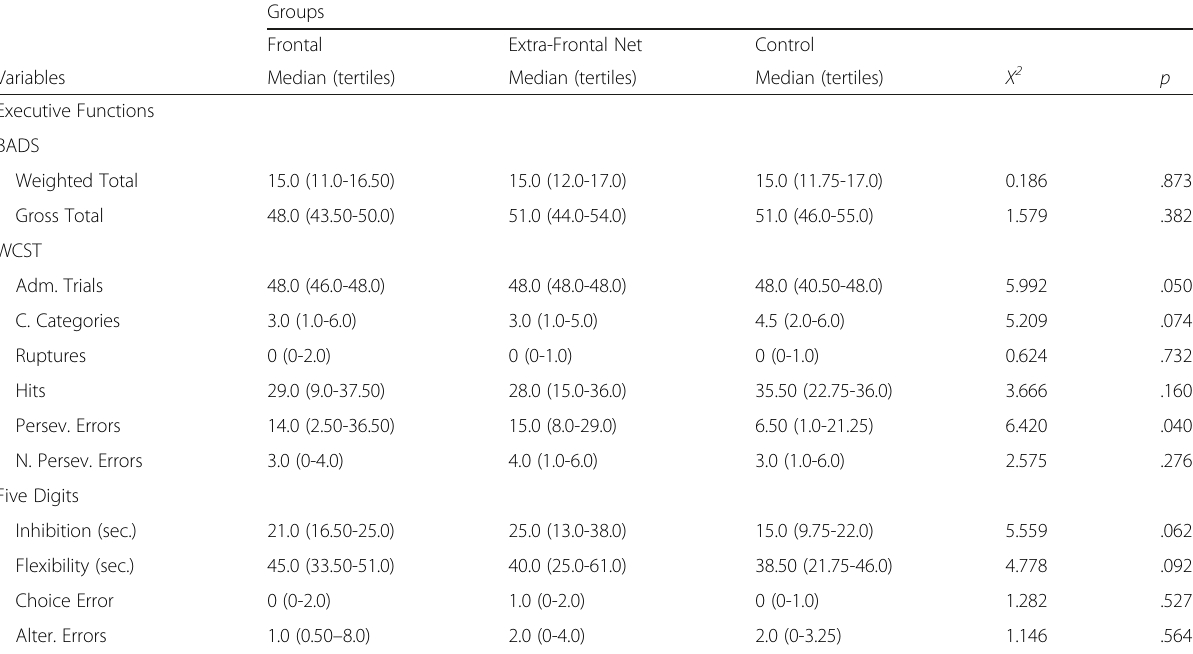
Table 3 Comparison among the three groups, regarding executive functions Groups Frontal Extra-Frontal Net Control